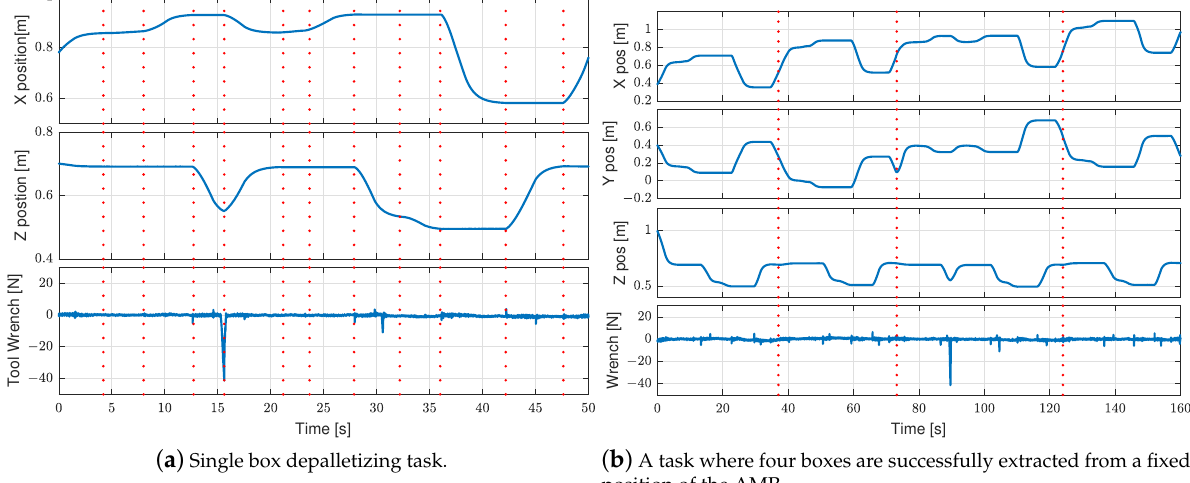
( a ) Single box depalletizing task. ( b ) A task where four boxes are successfully extracted from a fixed position of the AMR. Figure 10. Robot tool position and wrench during a depalletizing task of a single box ( a ) and four boxes ( b